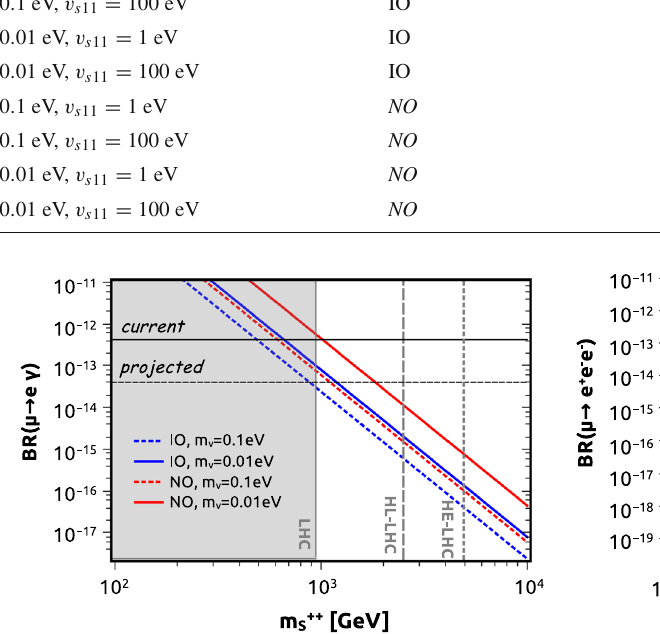
Fig. 1 Figures showing the predictions for μ → e γ (left-panel) and μ → 3 e (right-panel)decaysinourmodeloverlaidwiththeexistingand projected bounds from collider and lepton flavor violation searches. We used thelabelsIO(NO) for inverted(normal) massordering for theneu- trinos. LHC limitrefers tothecurrent LHC bound with36 f b − 1 of data.